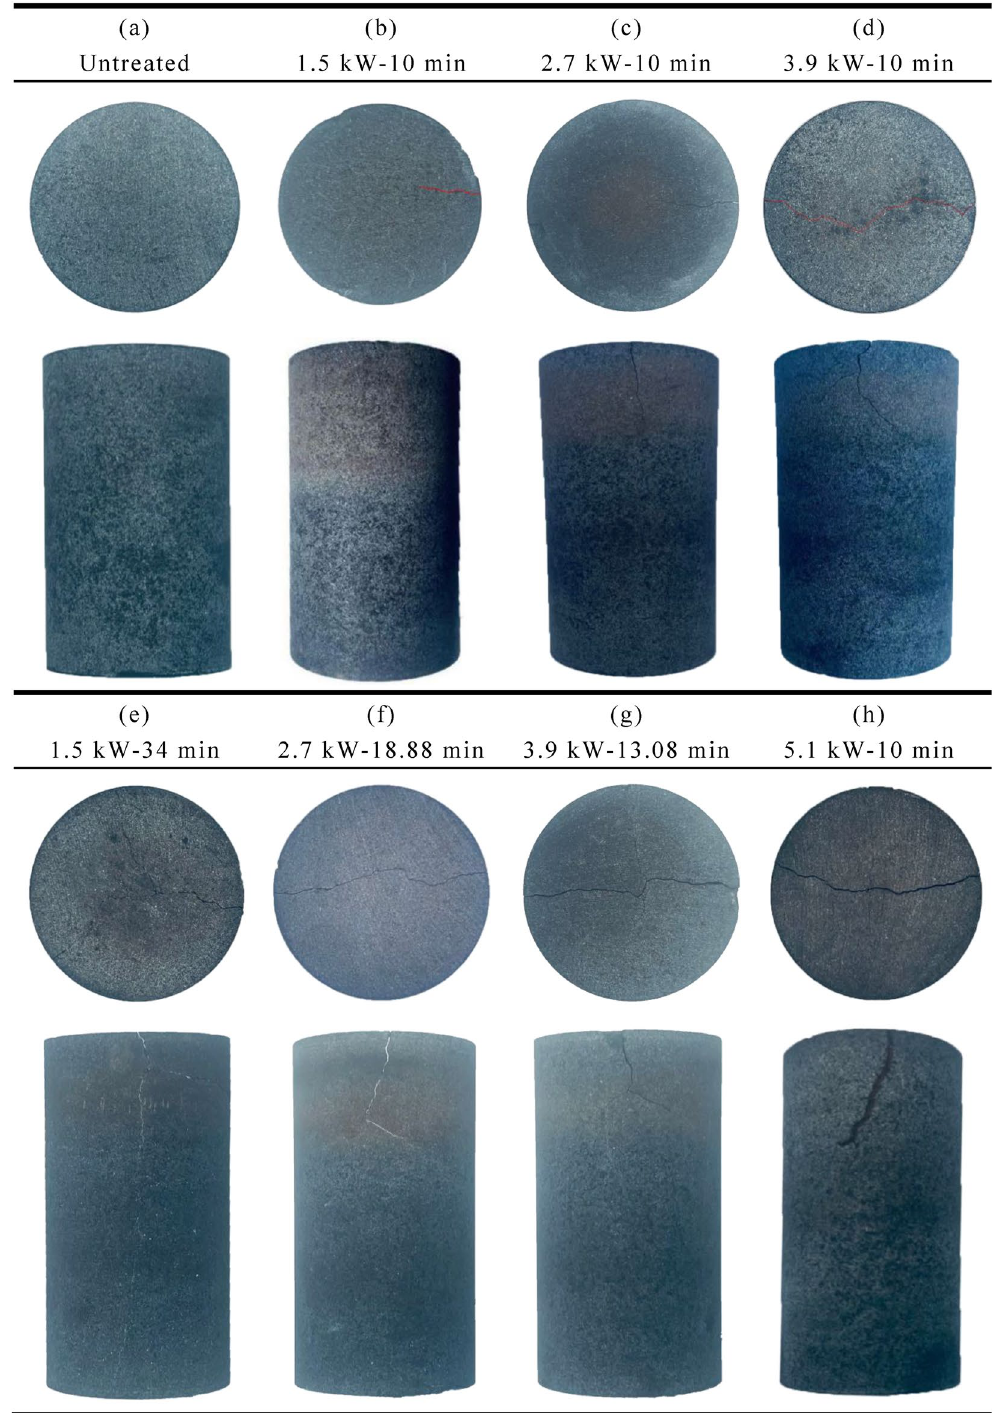
Figure 7. Basalt samples after microwave radiation: ( a ) Untreated; ( b ) at 1.5kW for 10 min; ( c ) at 2.7kW for 10 min; ( d ) at 3.9 kW for 10 min; ( e ) at 1.5kW for 34 min; ( f ) at 2.7 kW for 18.88 min; ( g ) at 3.9 kW for 13.08 min; ( h ) at 5.1 kW for 10